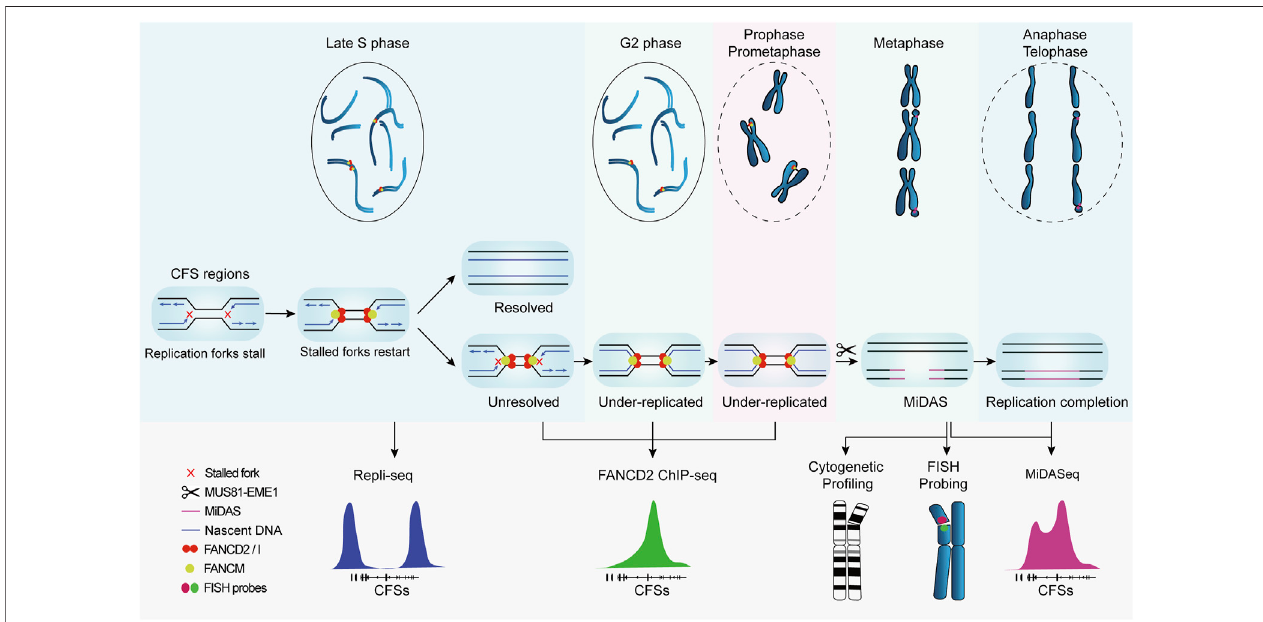
FIGURE 2 | Replication pro fi le of common fragile sites and corresponding methods for genetic mapping. CFSs tend to replicate at the late S phase. Under replicative stress, replication forks at CFSs slow down and stall. FANCM localizes to stalled forks and promotes fork reversal and restart, preventing DSB formation and CFSsinstability.Ifthestalledforksarenotresolved,CFSsremainunder-replicateduntilmitosis.Besides,FANCD2/IcomplexisalsorecruitedtoCFSregionsandpersists intomitosistoprotecttheunder-replicatedintermediates.MUS81-EME1endonucleasecomplexactivelycleavesunder-replicatedintermediatesandleadstoDSB formation, which is cytogenetically visible at metaphase chromosomes. Thereafter, mitotic DNA synthesis (MiDAS) is carried out to fi nish the replication and thus facilitates chromosomal segregation and genome stability.